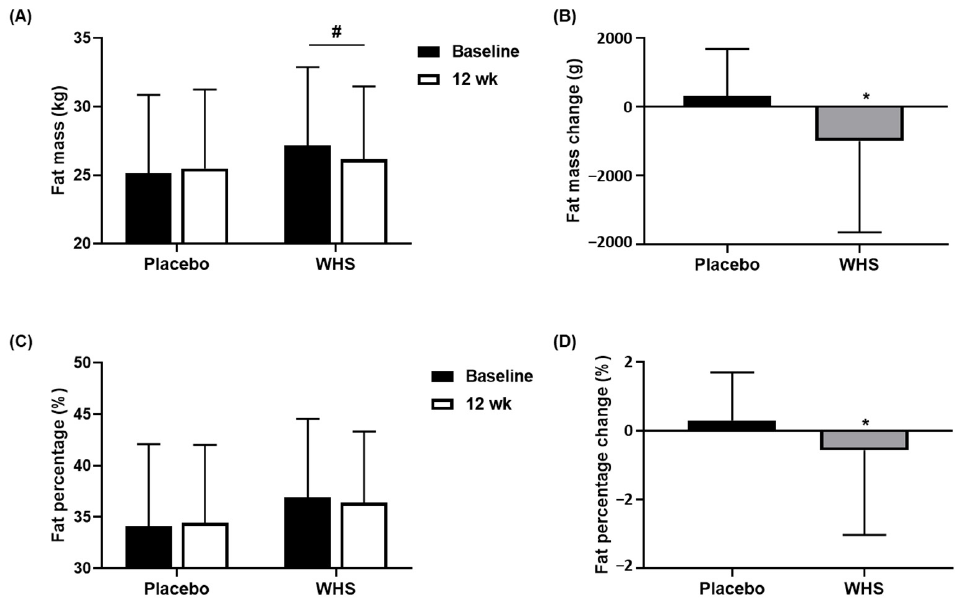
Figure 3. Changes in body fat masses and fat percentages. Changes in ( A , B ) fat mass and ( C , D ) fat percentage were measured in placebo- and WHS-treated groups at baseline and 12 weeks. Values are present as mean ± SD; # p < 0.05 derived from paired t -test within groups (Weeks 0 vs. 12), and * p < 0.05 derived from a two-sample t -test or Wilcoxon rank-sum test between groups (Placebo ( n = 45) vs. WHS ( n = 48)).